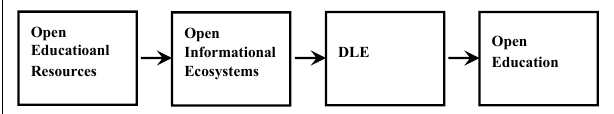
FIGURE 2 | An incremental representation of open educational resources (OER) and distributed learning ecosystems